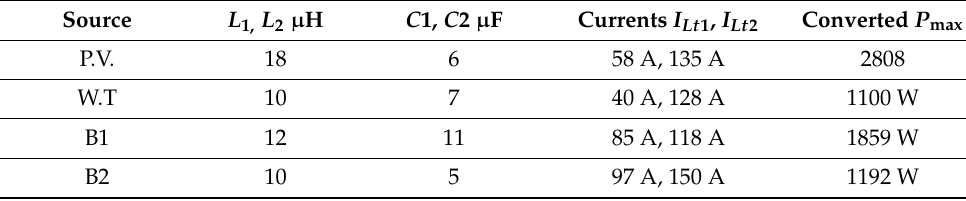
Table 2. Parameters obtained for the step-up mode design of the Uc and Bc.